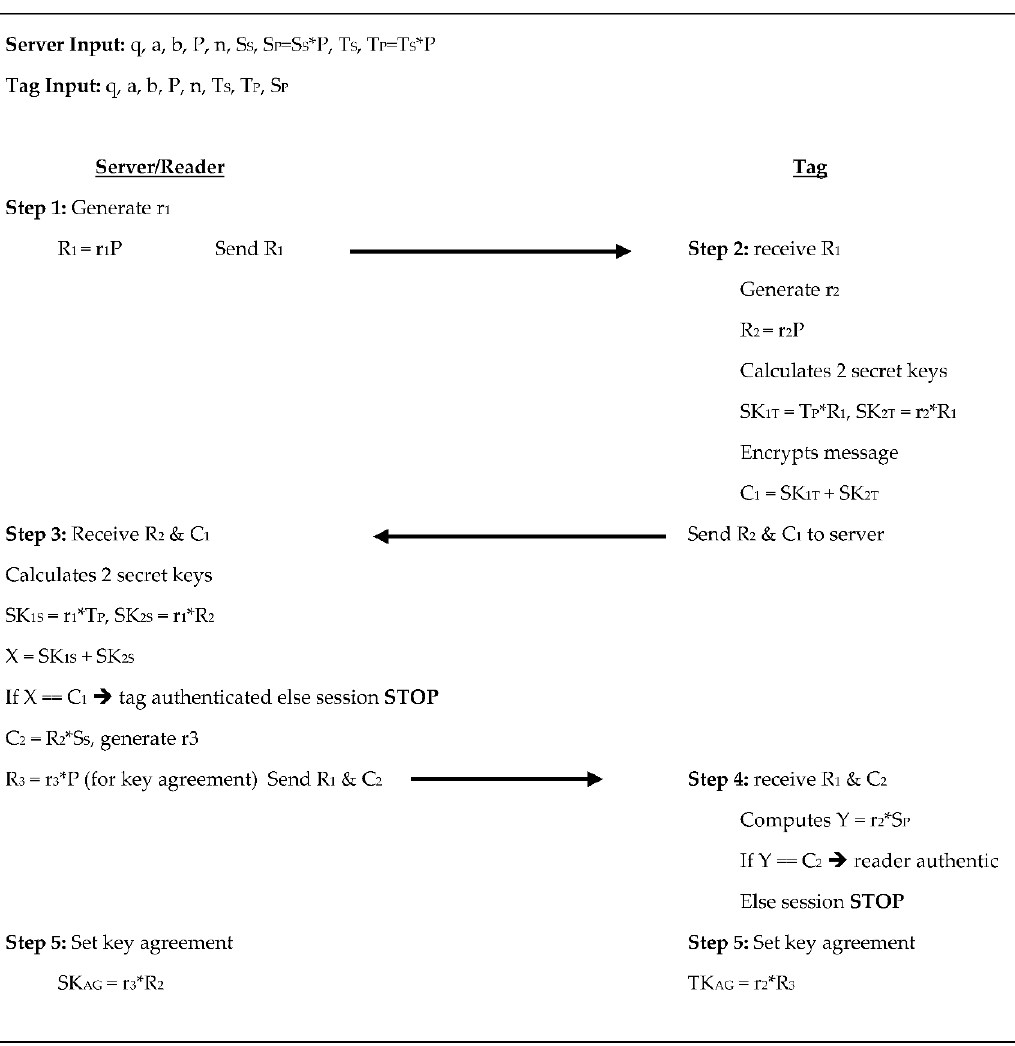
Figure 2. Authentication phases for Alamr et al. [4].